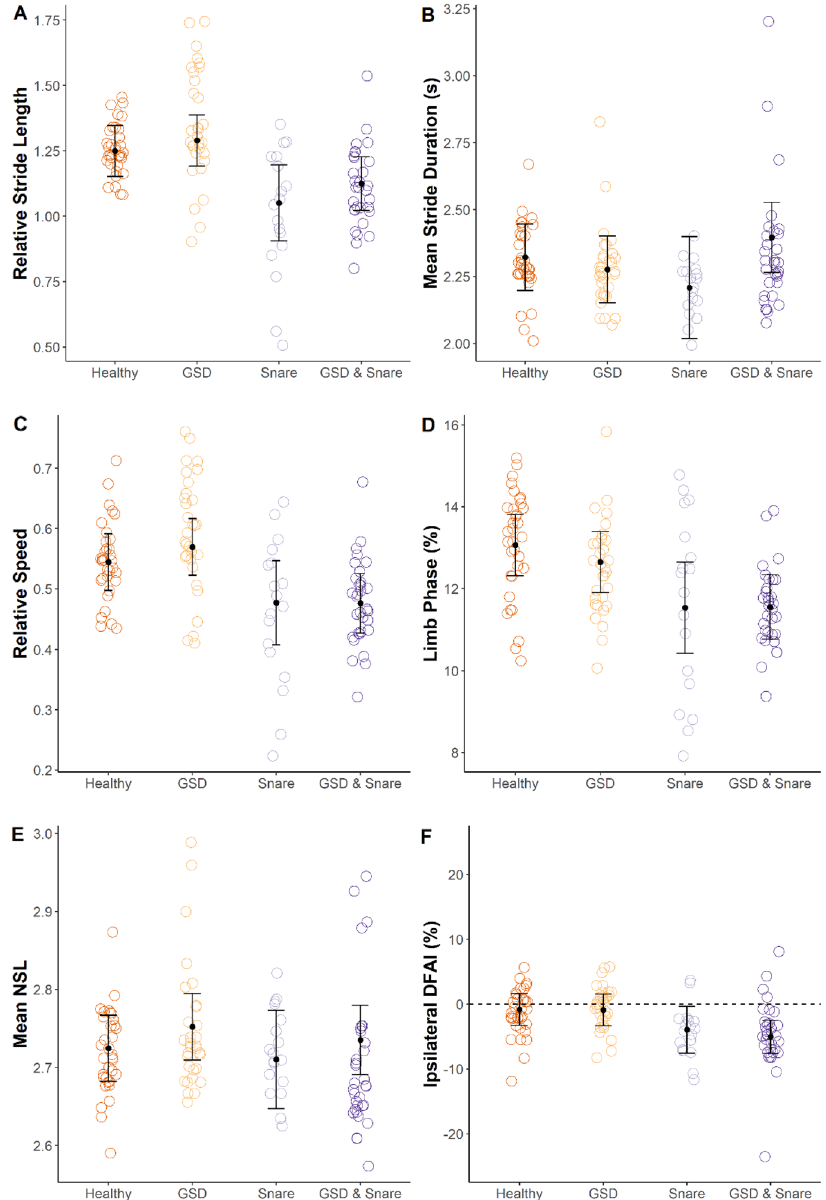
Figure 4. Variation in spatiotemporal limb kinematics among different conditions (i.e., healthy, GSD, snare wound, and both GSD and snare wound) in free-ranging Nubian giraffe Giraffa camelopardalis camelopardalis from Murchison Falls National Park, Uganda. Each point represents a stride. Black dots indicate estimated marginal means and black error bars indicate 95% confidence intervals from the linear mixed models. Black dotted line in panel F indicates contralateral symmetry.